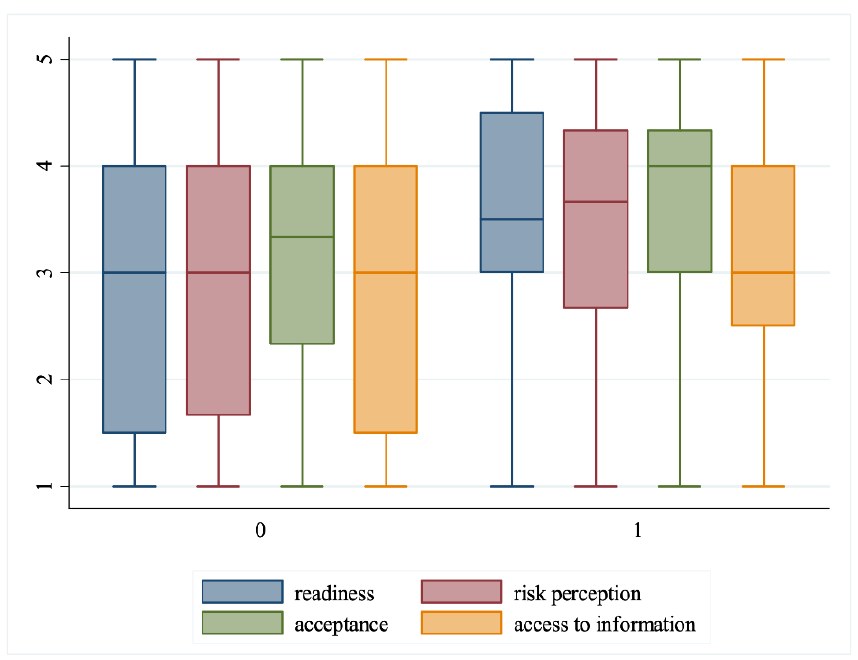
Figure 4. Box plots of the model variables readiness, risk perception, acceptance of storm naming, and access to information, among the population sample without previous negative experience (0) and with previous negative experience (1). Table 2. Regression results explaining individual readiness for named